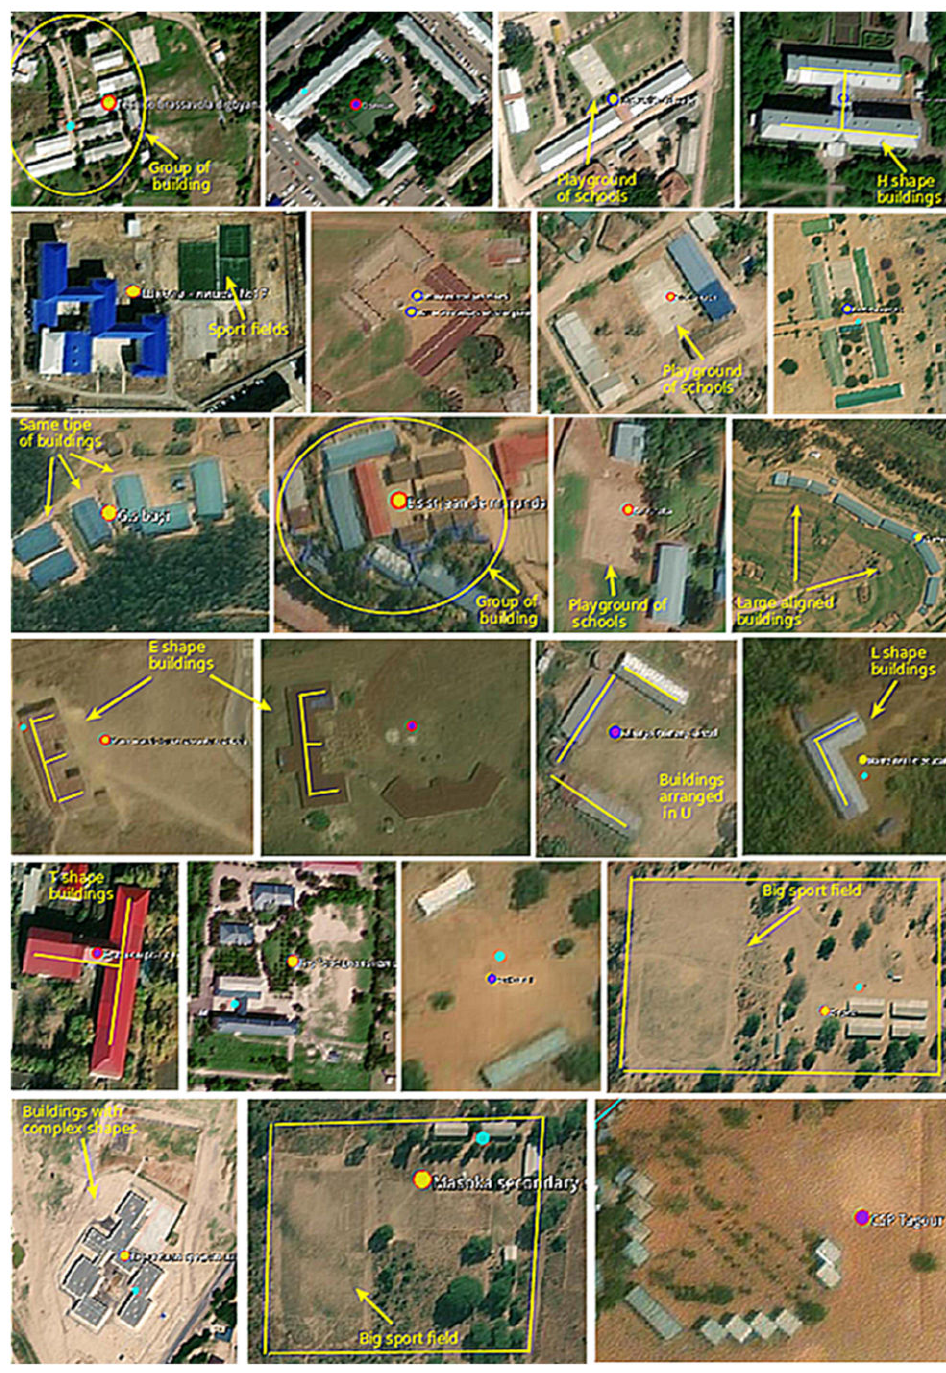
Figure 1. School location structure showing identifiable signatures on overhead